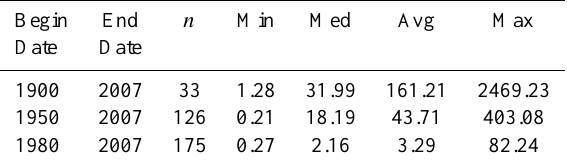
Table 2a. Basic statistics regarding trends in normalized national FFCO2 emissions for different time periods. n = number of coun- tries which existed at both the beginning and end dates, min = min- imum annual growth factor for the n countries (equal country weighted, not weighted by mass per country), med = median annual growth factor, avg = average annual growth factor, max = maximum annual growth factor. The growth factor is defined as the end date FFCO2 emissions divided by the begin date FFCO2 emissions. A factor of one indicates emissions were equal at the begin and end dates. A factor of two indicates that emissions doubled over the time period. It should be noted that available data for gas flaring and cement production vary by country. In some cases, inclusion of FFCO2 from these sources is sizable (e.g., gas flaring for Middle Eastern countries in the 1970s). Thus, growth factors may also re- flect new sources (e.g., there is no gas flaring data in 1900, but it does occur in many countries in 2007. Thus, the 1900–2007 growth factor statistics includes the addition of gas flaring.). Data from Bo- den et al. (2010).